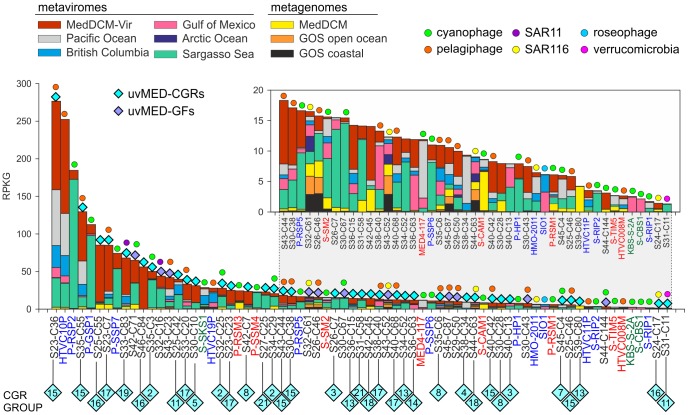
Comparative fragment recruitment of CGRs, GFs contigs (genome fragments of incomplete phage genomes) and representative cultivated phage genomes.Number of reads recruited by each, expressed as RPKG (Reads per Kb per Gb) from several metaviromes and metagenomes (color coded). Only hits that had >95% identity, minimum length of 50 bp and e-value<1e-5 were considered in this analysis. The names of the fosmid contigs are abbreviated as before. The reference genome names are highlighted in color according to their family (blue, Podoviridae; green, Siphoviridae and red, Myoviridae). Blue diamonds on top of the bars mark the contigs identified in this study with different colors (cyan, CGRs; purple, GFs) and the predicted (or known) host is also indicated when possible. Inset is a magnified view of the lesser recruiting fragments.